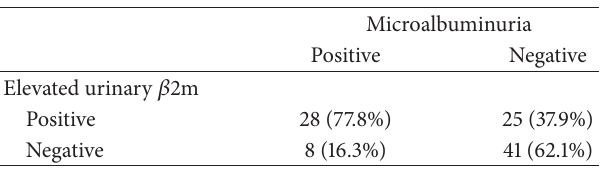
Table 6: Comparison of urinary 𝛽 2m and microalbuminuria in detecting early